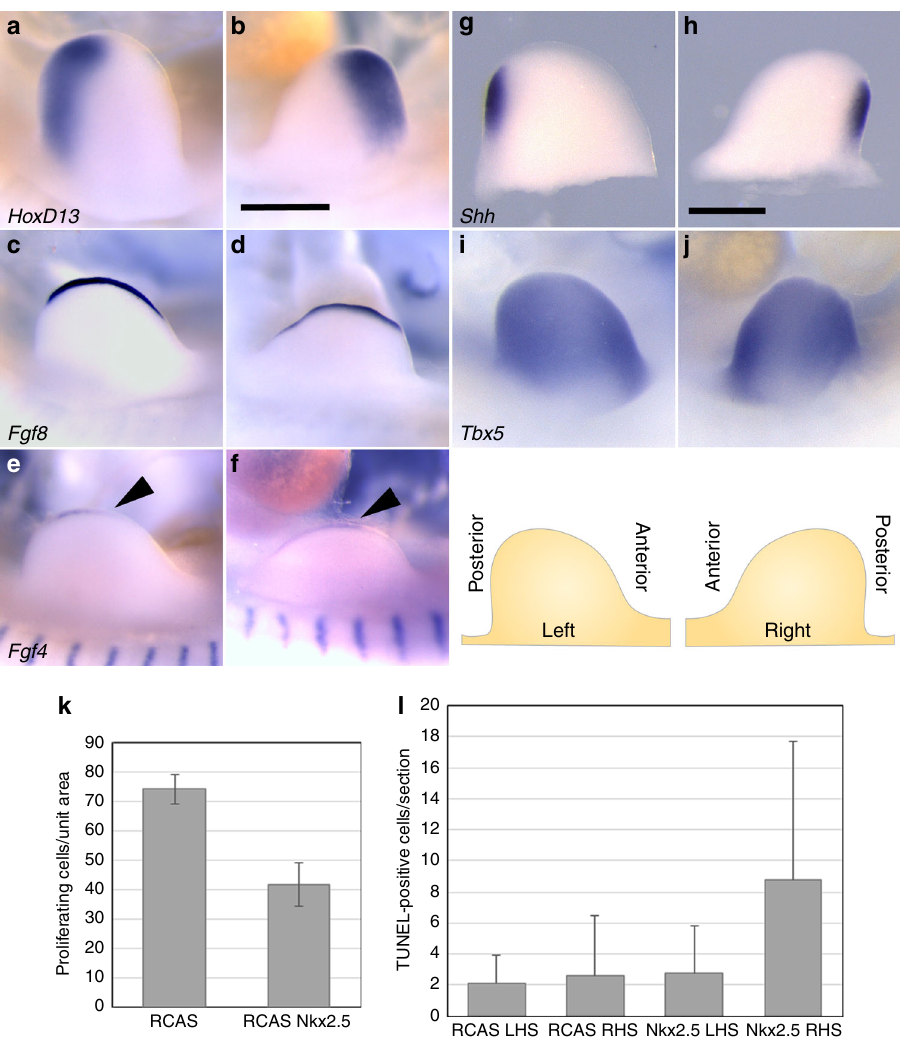
Fig. 7 Impact of Nkx2.5 mis-expression on expression of essential limb-patterning genes. In situ hybridization of forelimb buds 2 days after infecting the right wing bud with Nkx2.5 -expressing virus. a , c , e , g , i left (uninfected) and b , d , f , h , j right (infected) forelimb buds of the same embryo. a , b HoxD13 , c , d Fgf8 , e , f Fgf4 , g , h Shh , i , j Tbx5 ( n = 3 for HoxD13, Fgf4 and 8, n = 9 for Shh). Orientation of limb buds is as illustrated bottom right . k Nkx2.5 expression reduces proliferation in limb bud mesenchyme. Control limb bud mesenchyme possesses 74.1 ± 4.8 (mean ± SD, n = 3) proliferating cells per unit area, while Nkx2.5 -expressing limb buds have 41.7 ± 7.3 proliferating cells per unit area ( n = 5). l Cell death in response to Nkx2.5 mis-expression in chick limb buds (mean ± SD, n = 3 for control and Nkx2.5-expressing embryos). Statistical signi fi cance calculated using Student ’ s t -test. Scale bars = 0.5